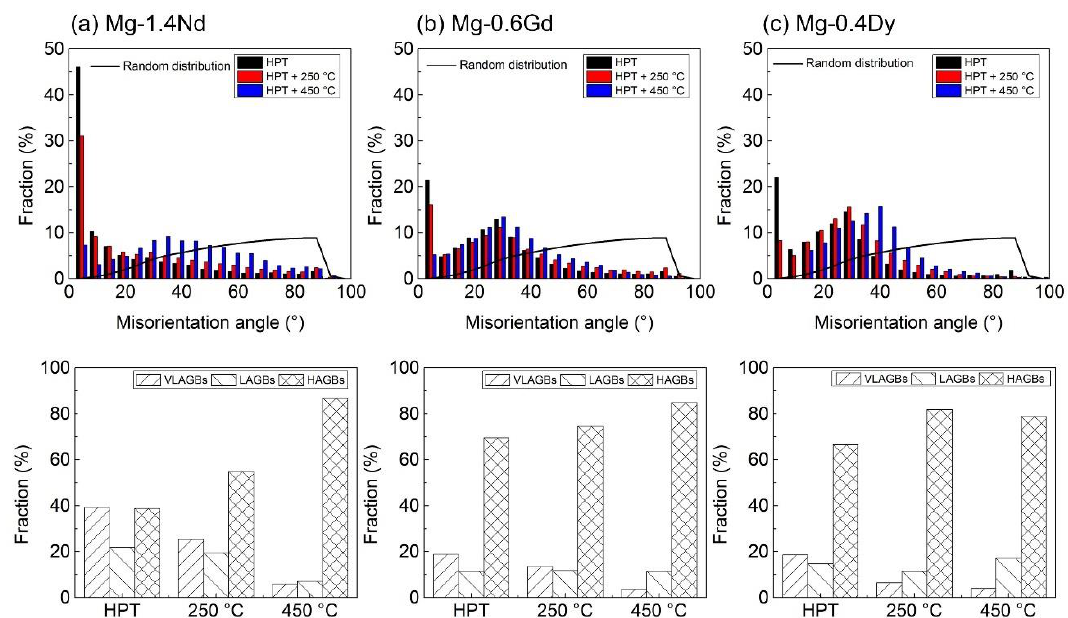
Figure 4. Grain boundary misorientation angle distributions and fractions of VLAGBs, LAGBs, and HAGBs of samples HPT-processed and annealed at 250 and 450 °C for 1 h: ( a ) Mg-1.4Nd, ( b ) Mg- 0.6Gd, and ( c ) Mg-0.4Dy alloys.